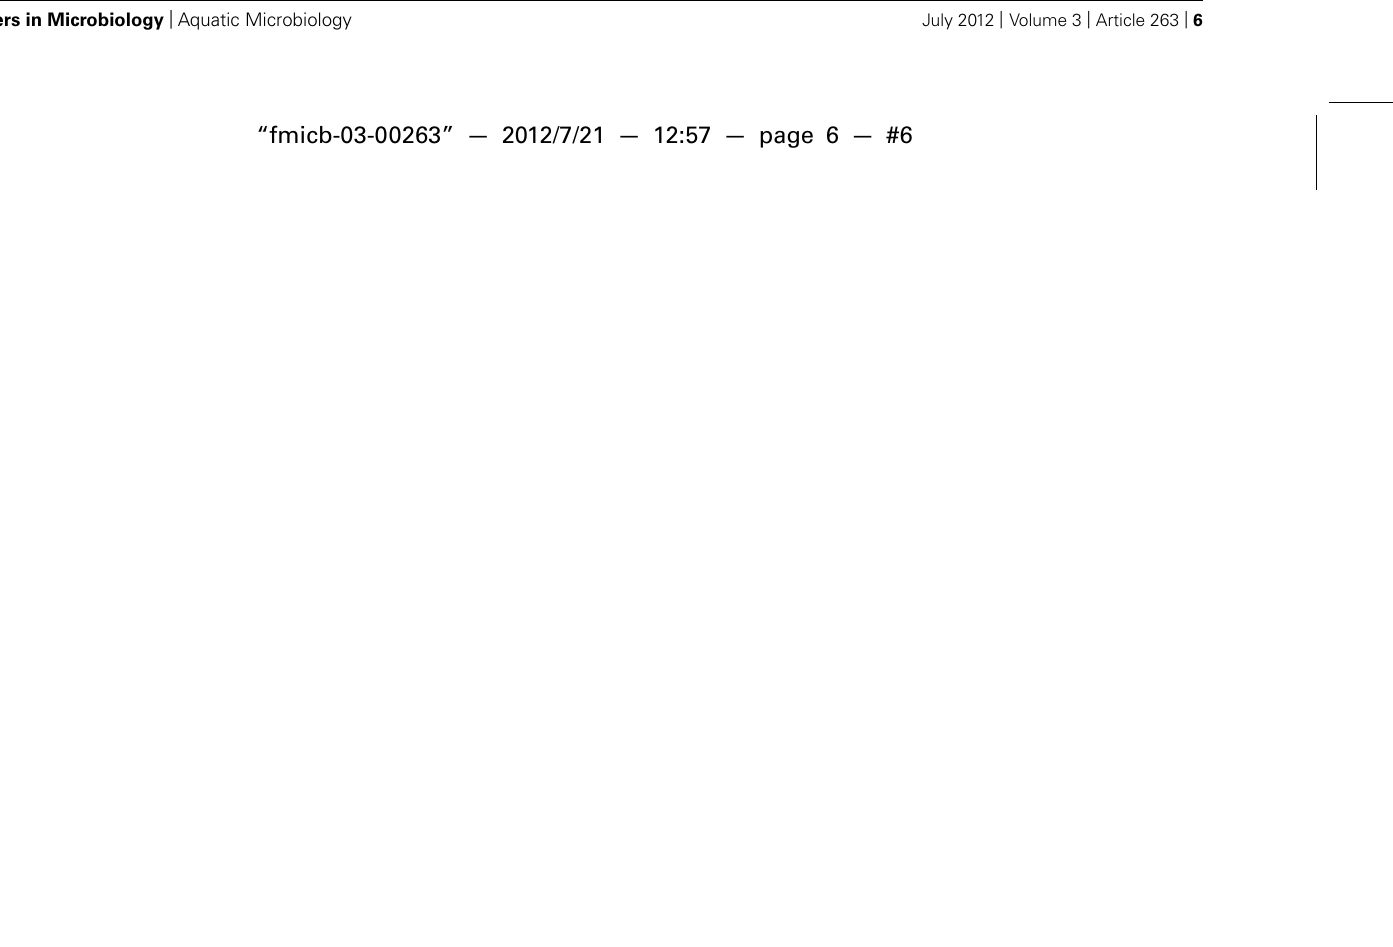
FIGURE 3 | Sediment profiles of dissolved inorganic nitrogen and ammonia oxidizers. Average pore water [ NH + 4 ] is shown for Bird Rock in 2007 (A) , Catalina Harbor in 2007 (E) , and Catalina Harbor in 2008 (I) , and pore water [ NO − 3 + NO − 2 ] is shown for Bird Rock (B) , Catalina Harbor in 2007 (F) , and Catalina Harbor in 2008 (J) . Archaeal amoA genes (g-sediment − 1 ) are shown for individual cores collected at Bird Rock (C) , Catalina Harbor in 2007 (G) , and Catalina Harbor in 2008 (K) . Bacterial amoA genes (g-sediment − 1 )